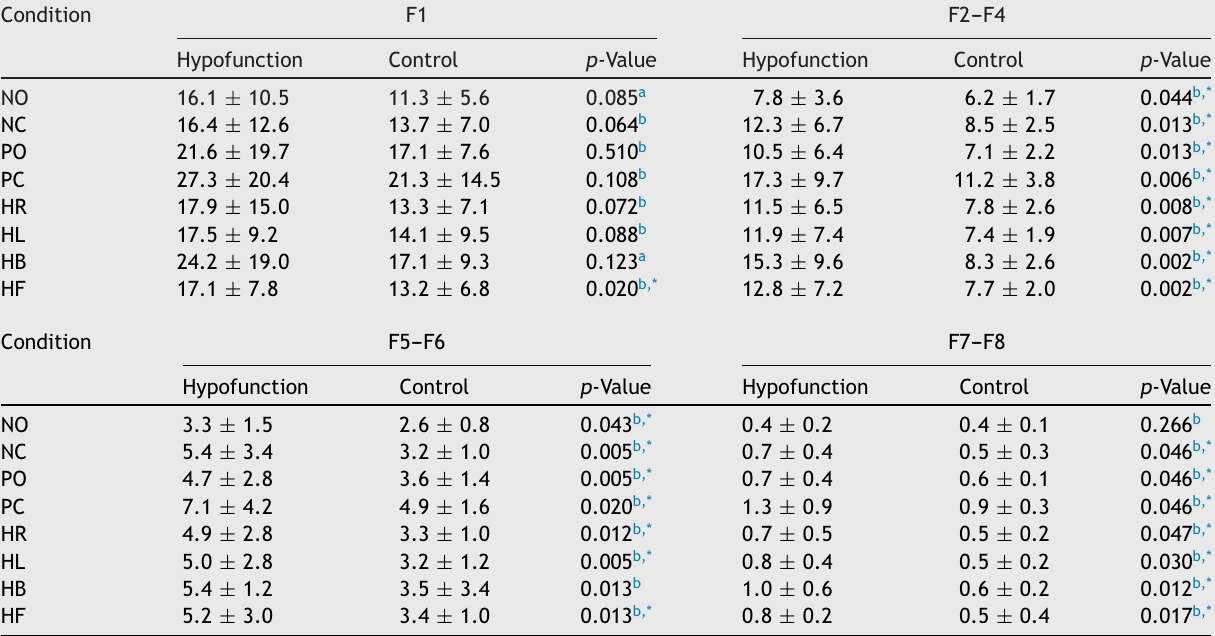
Comparative analysis of Fourier frequency bands in the eight conditions of the Tetrax Interactive Balance System (Tetrax TM ) in 32 control subjects and 25 patients with vertigo and unilateral vestibular hypofunction in the experimental group.